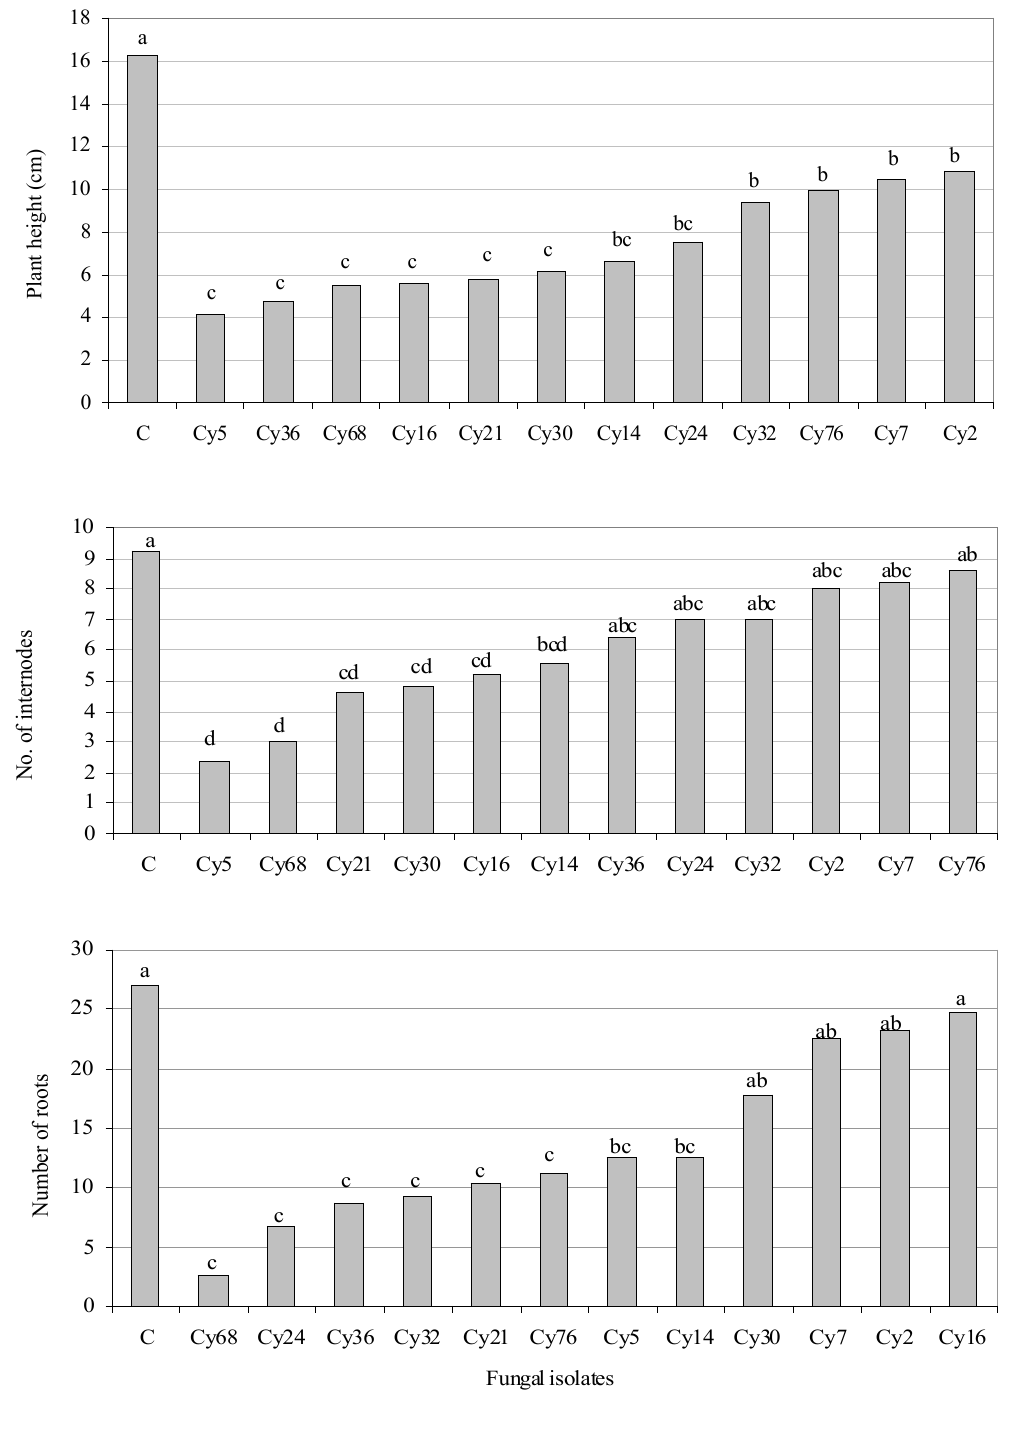
Fig. 3. Effect of Cylindrocarpon destructans isolates on plant height, number of internodes and number of roots in inoculated grapevine cuttings of cv. Periquita. C, control, Cy, C. destructans